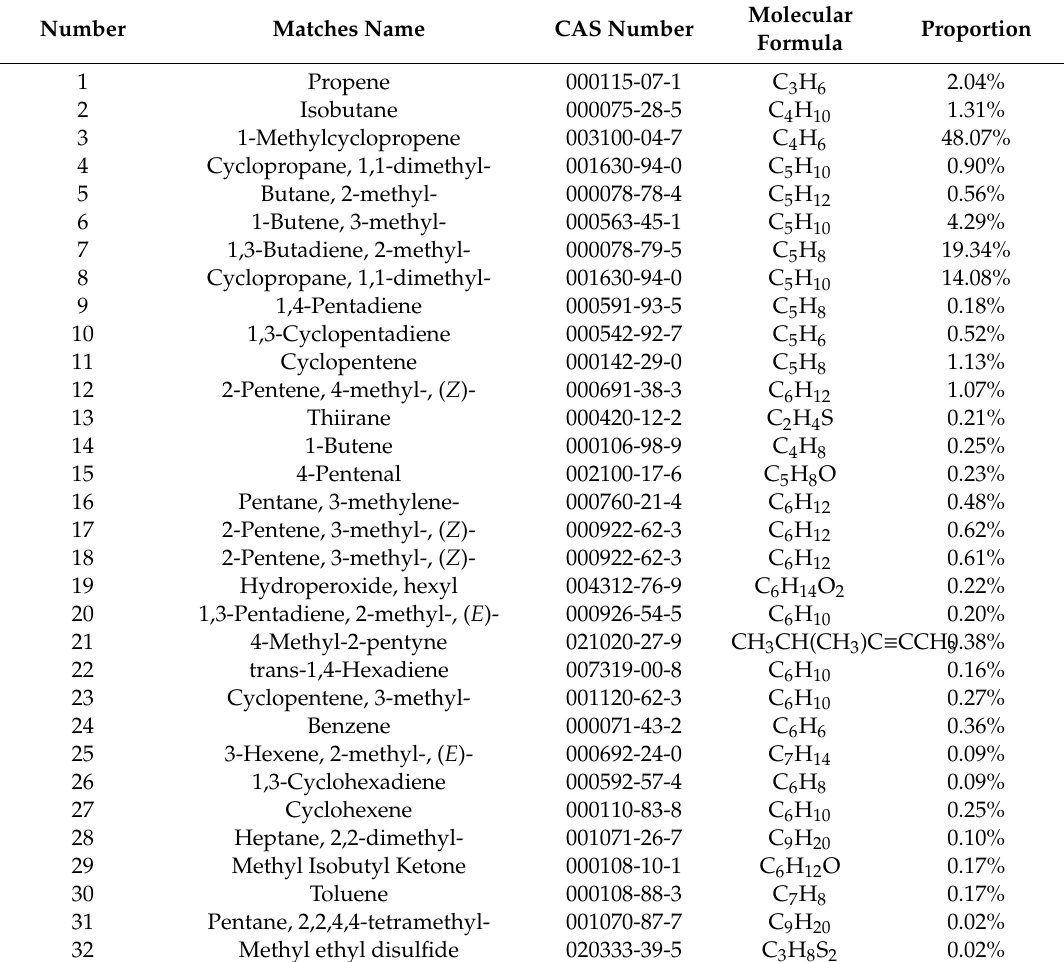
Table 6. Pyrolysis gas components and content in Experiment